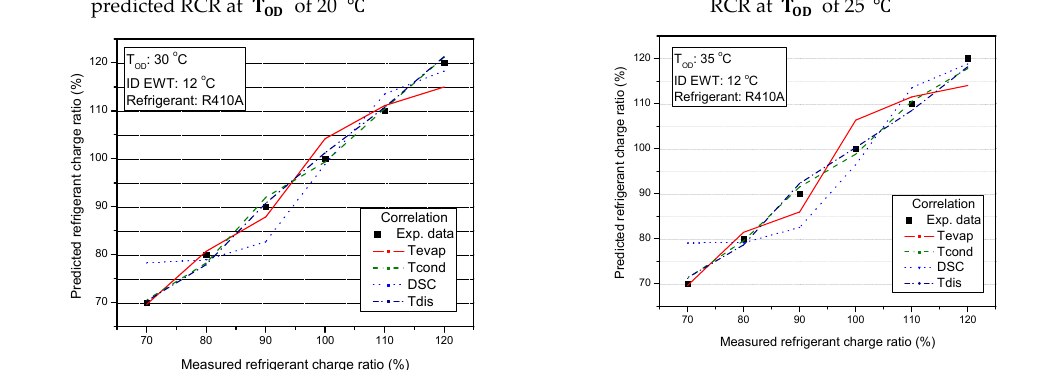
( c ) Comparison between experimental and predicted RCR ( d ) Comparison between experimental and predicted